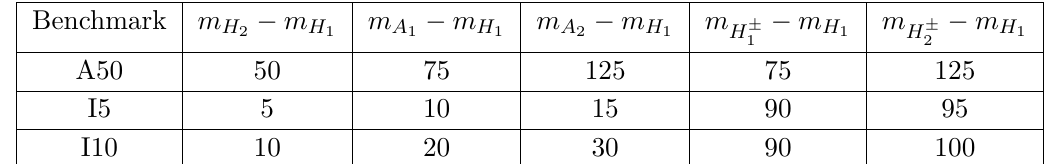
Table 1 . De(cid:12)nition of benchmark scenarios with the mass splittings shown in GeV. o(cid:11)-shell. Further decreasing of the H